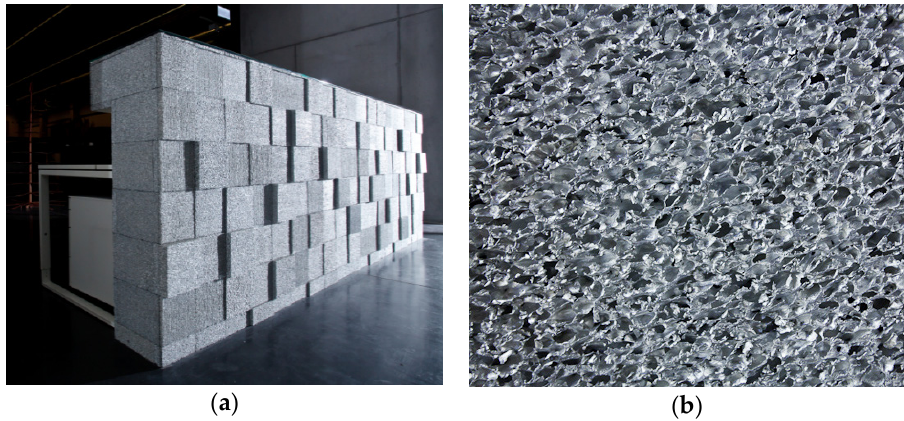
Figure 19. ( a ) Reception desk from Aluinvent made of Aluhab foam with a bubble size of 3 mm built for Market Zrt. Budapest, Hungary; and ( b ) detail of the foam surface structure (courtesy of Norbert Babcsán, Aluinvent).